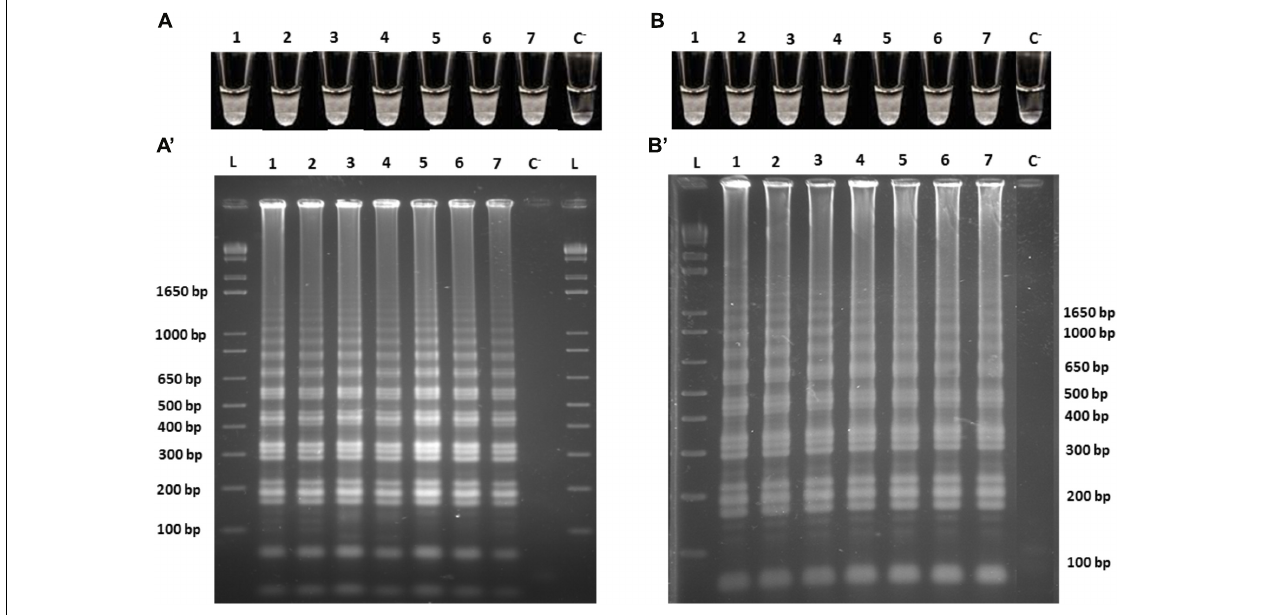
FIGURE 3 | Cells-LAMP amplifications from the 10-fold serial dilutions of the O. oeni lysed cells in (A) white wine, and (B) red wine. A, B, direct turbidity observation; A (cid:48) , B (cid:48) , agarose gel electrophoresis of the amplified products; 1, 10 8 cells/mL; 2, 10 7 cells/mL; 3, 10 6 cells/mL; 4, 10 5 cells/mL; 5, 10 4 cells/mL; 6, 10 3 cells/mL; 7,